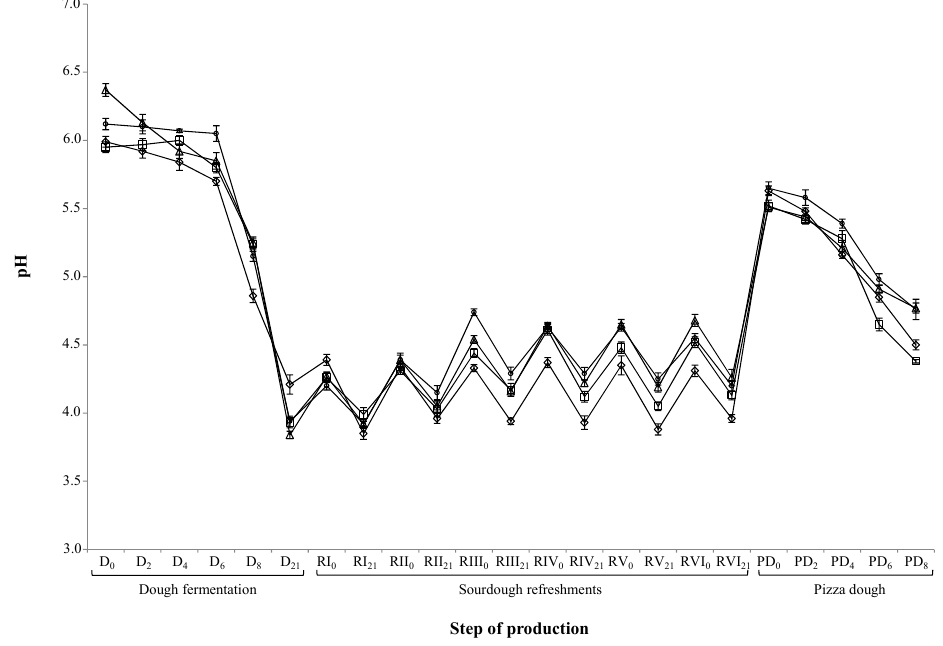
Figure 1. Evolution of pH during the dough preparation, sourdough propagation, and pizza dough production. Symbols: rhombus—control (CTR)-semolina; triangle—obligate heterofermentative species (OHS)-semolina; circle—facultative heterofermentative species (FHS)-semolina; square—obligate–facultative heterofermentative species (OFHS)-semolina.